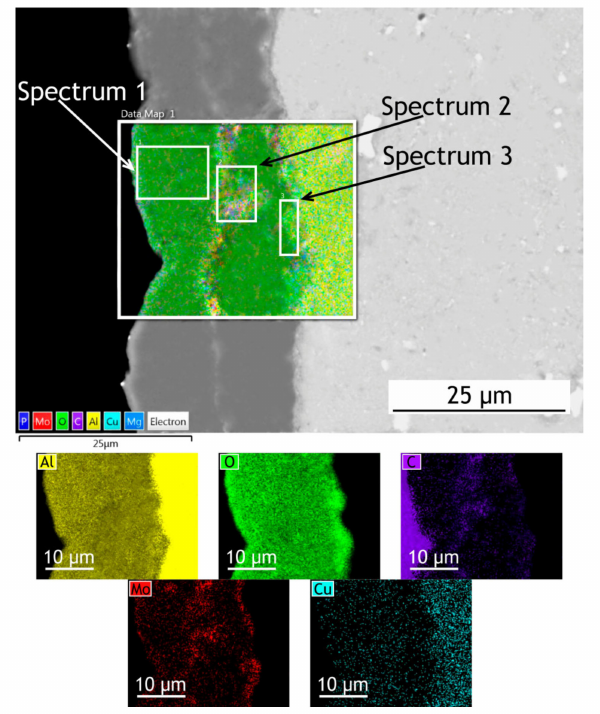
Figure 4. SEM image and EDX maps of the PEO-coatings’ cross-section.